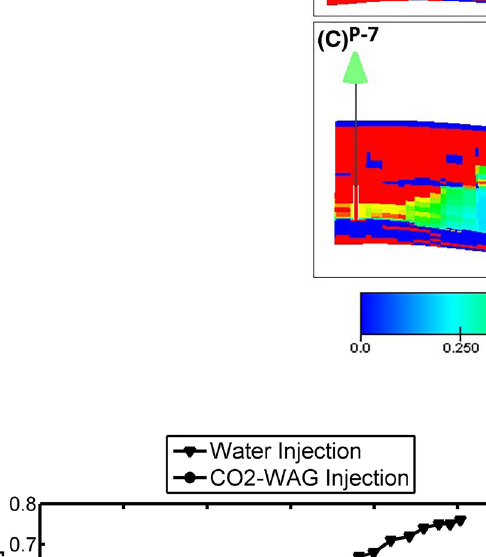
Fig. 12 Oil saturation on a plane intercepted by the wells P-7, I-1 and P-1. a Starting oil saturation. b – d oil satura- tion after 6 months, 5 years and 10 years of production, respectively